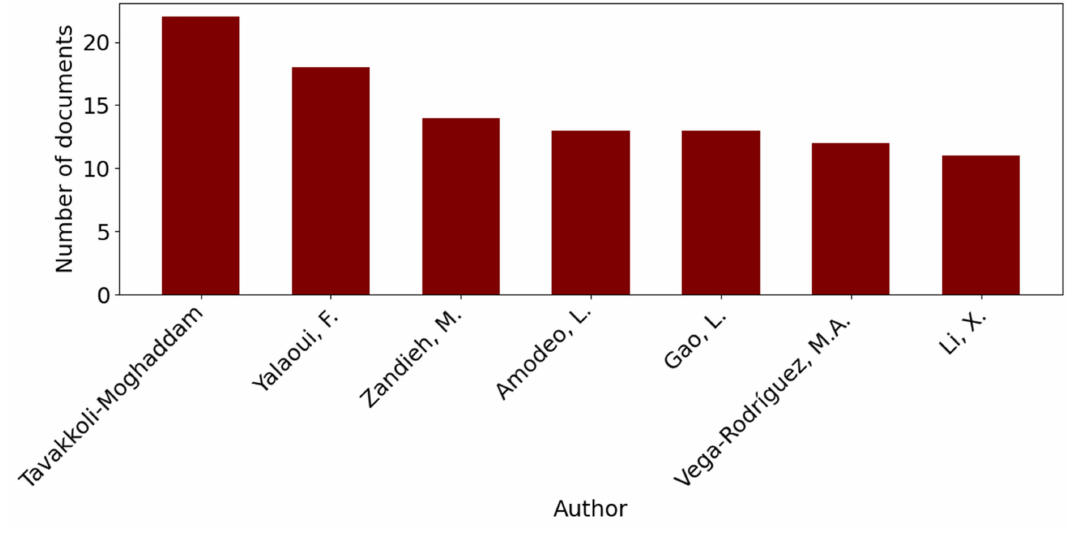
Figure 15. The most active authors in the field (Scopus https://www.scopus.com).